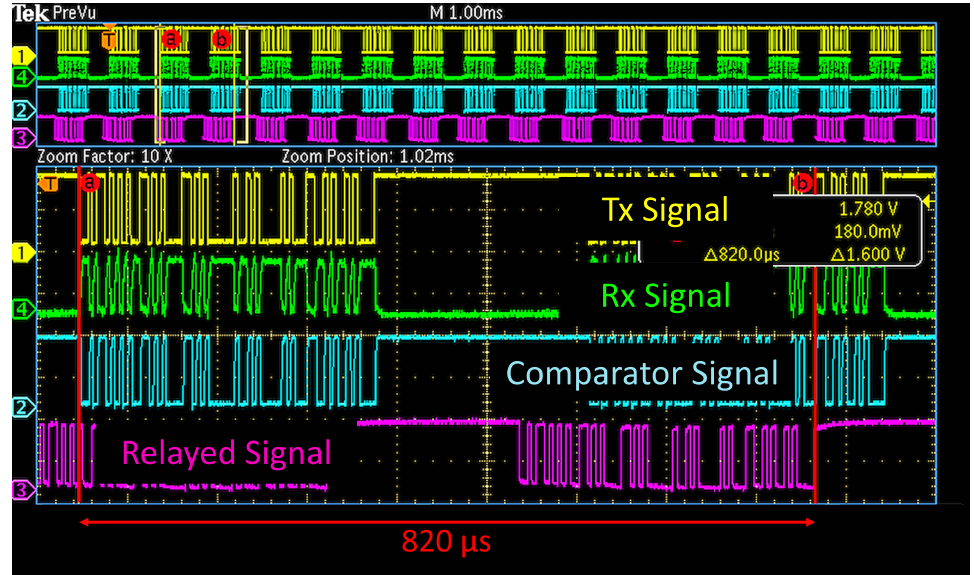
Figure 5. Information broadcast: oscilloscope screen showing the repeatedly transmitted signal (yellow), received signal (green), digitized signal (blue) and relayed signal (purple). The observed latency is 820 microseconds at 230 kbaud for the full Active Decode and Relay (ADR)